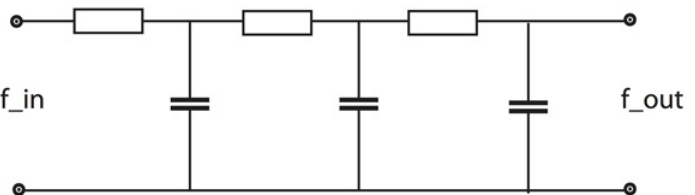
Fig 3. Electric wiring diagram consisting of a set of resistors and capacitors that emulate a series of first-order integrators coupled in cascade. Here, we regard the time-varying voltage f in as representing the time varying input signal and the resulting output voltage f out as representing the time varying output signal at a coarser temporal scale. According to the theory of temporal scale-space kernels for one-dimensional signals (Lindeberg [42]; Lindeberg and Fagerström [44]), the corresponding equivalent truncated exponential kernels are the only primitive temporal smoothing kernels that guarantee both temporal causality and non- creation of local extrema (alternatively zero-crossings) with increasing temporal scale. Such first-order temporal integration can be used as a straightforward computational model for temporal processing in biological neurons; see also (Koch [46], chapters 11 – 12) regarding physical modelling of the information transfer in dendrites of